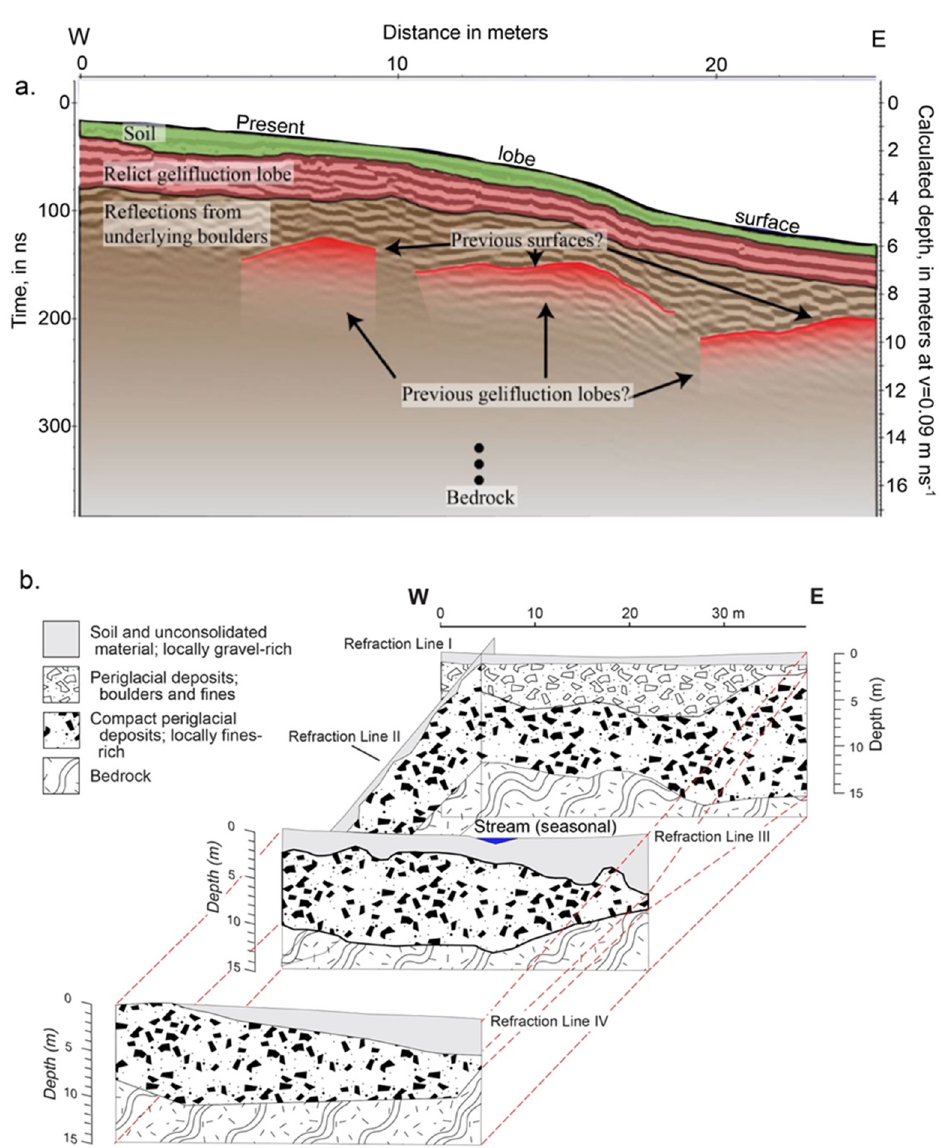
Figure 3. Subsurface model of Niwot Ridge from geophysical measurements. ( a ) Geologic interpretation of ground-penetrating radar line (modified from [26], p.116, Fig. 68b ) from 100 m SW of SADL 1 (see Figure 2). (Adapted with permission from Gabe Lewis, Copyright 2013 to Gabe Lewis). ( b ) Fence diagram showing inferred layering of the upper critical zone near upper Como Creek, based on shallow seismic reflectometry (SSR) measurements (Reprinted/adapted with permission from ref. [21], p. 522, Figure 3. Copyright 2008 Arctic, Antarctic, and Alpine Research).